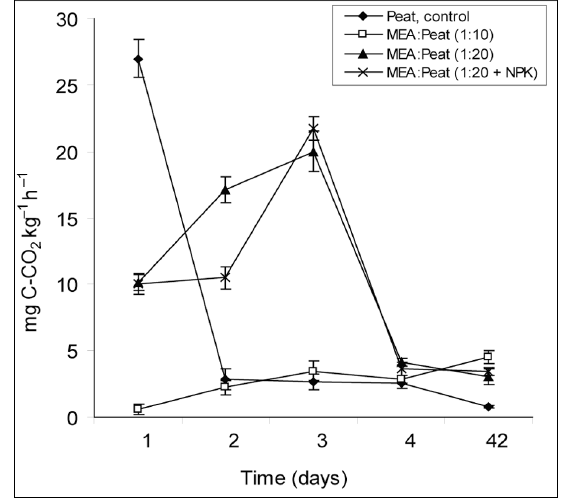
Fig. 4. Respiration rate of the acid (pH 3.1) peat, MEA: peat mixture (ratio 1:10 and 1:20) and MEA: peat (ratio 1:20) en- riched with the NPK fertilizers